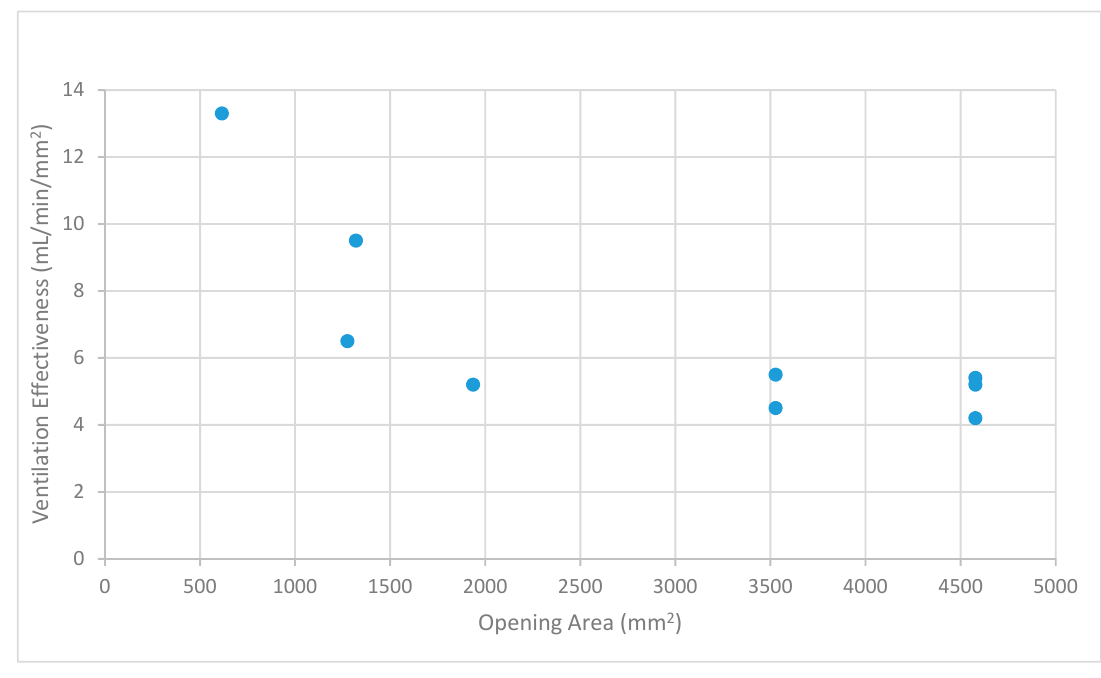
Figure 7. Ventilation effectiveness/efficiency. Effectiveness/efficiency of ventilation of isolated subsurface structures induced by natural forces is not constant and reflects the number of openings in the access manhole cover.